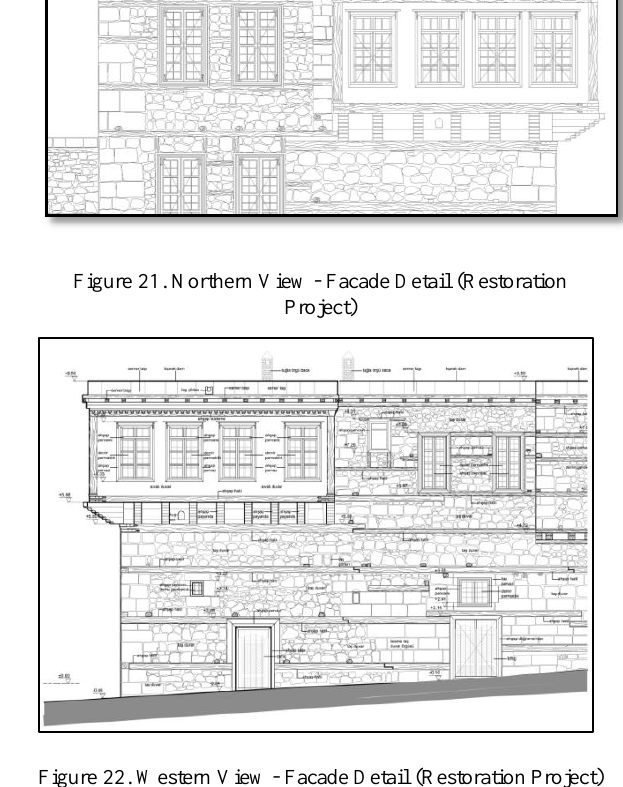
Figure 22. Western View - Facade Detail (Restoration